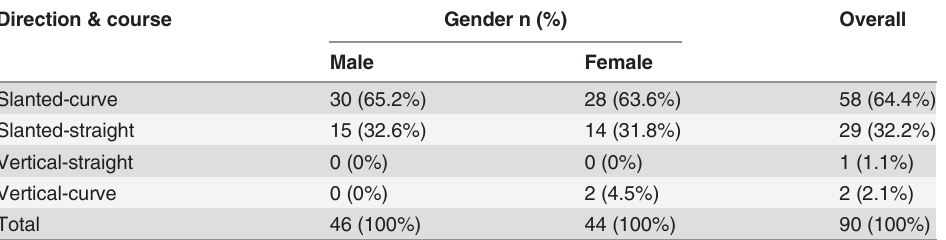
Table 3. Distribution of the different directions and courses of the ICs in males and